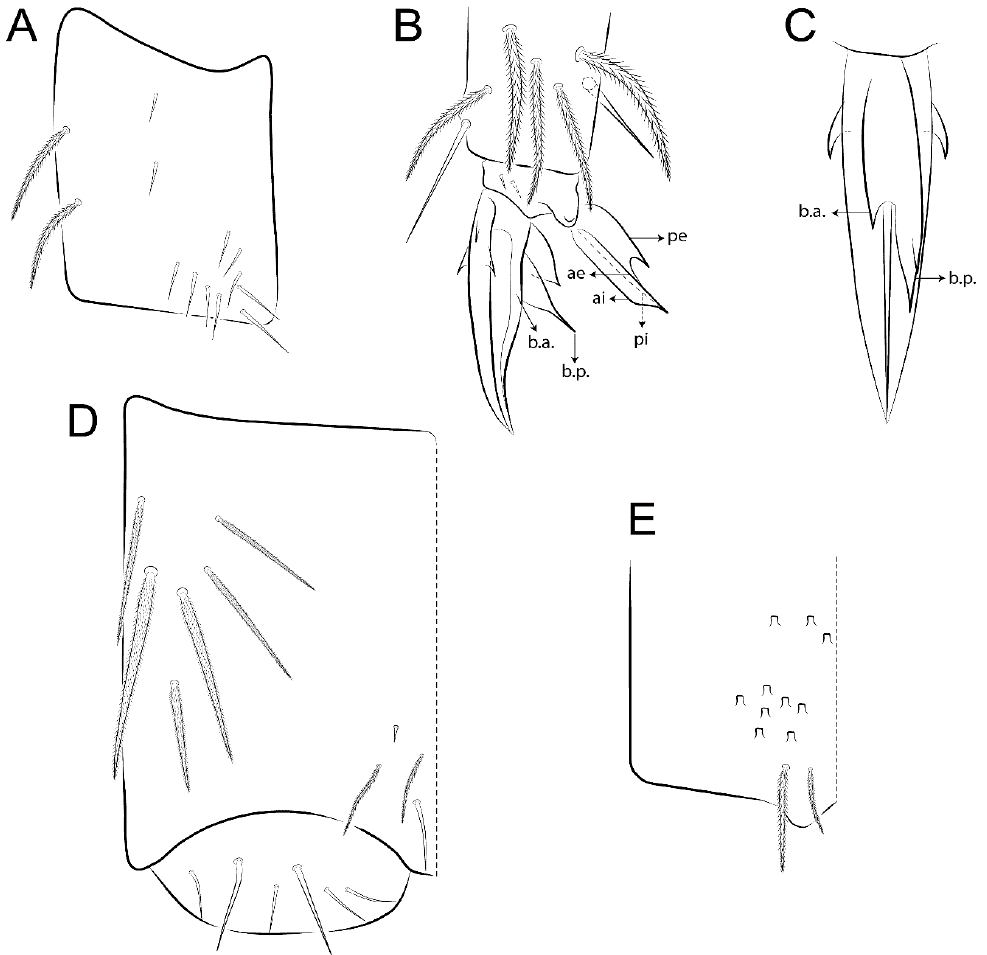
Figure 18. Pseudosinella keni sp. nov.: trunk appendages. ( A ) trochanteral organ; ( B ) distal tibiotarsus and empodial complex III (anterior view); ( C ) unguis (inner view); ( D ) collophore (lateral view); ( E ) distal part of manubrium (ventral view).